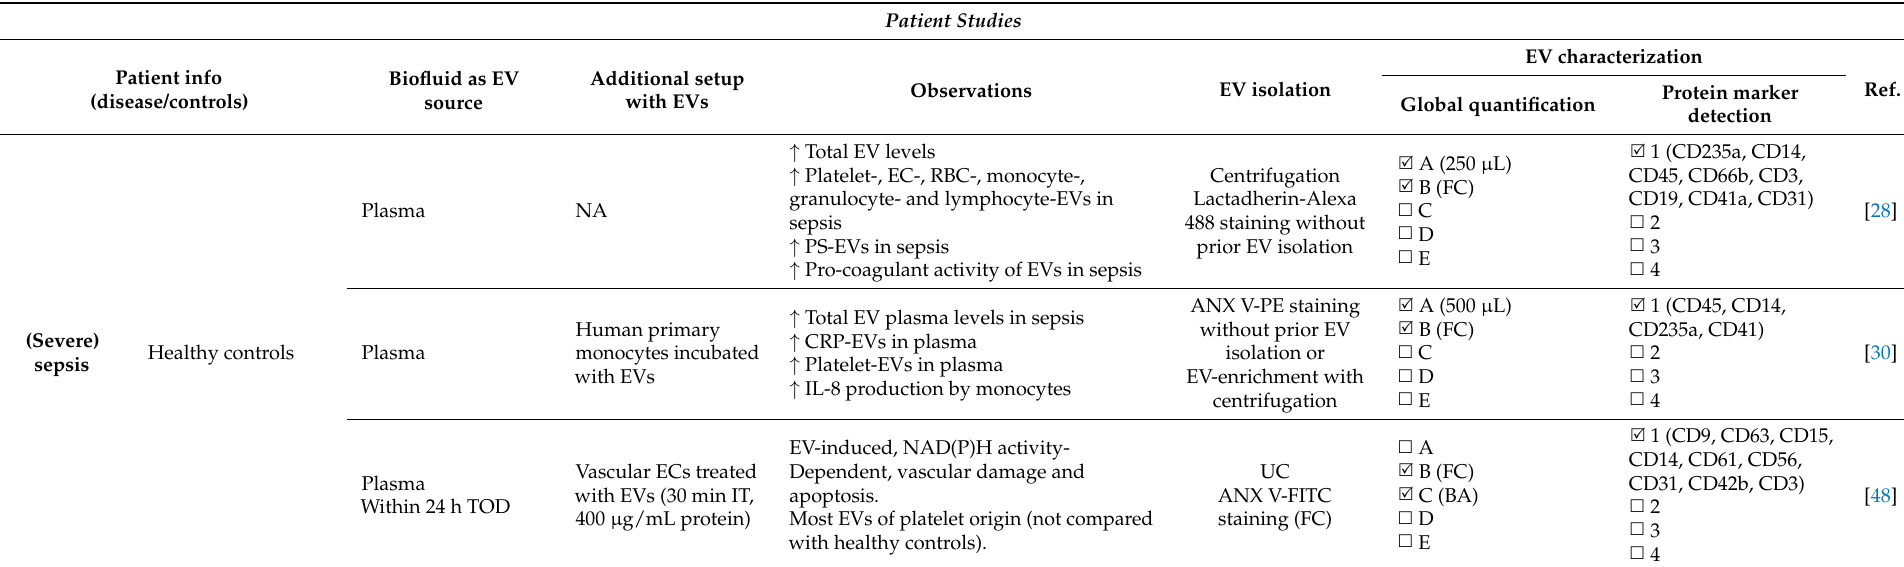
Table 3. Minimal Information for Studies of EVs (MISEV) guidelines related information about EV isolation and characterization in the studies discussed in this review, investigating human-derived EVs. When the effects of human EVs were validated in mice or cell cultures, this is mentioned as ‘additional setup’. For global quantification requirements, consult checkboxes A–E. Checkbox A: Cell number/fluid volume/tissue mass from which EVs were isolated. Checkbox B: Analysis of particle number. Checkbox C: Analysis of protein amount. Checkbox D: Analysis of lipid amount. Checkbox E: Analysis by electron microscopy. For information regarding protein marker detection, consult checkboxes 1–4. Checkbox 1: Transmembrane or Glycosylphosphatidylinositol (GPI)-anchored protein(s) localized in cells at plasma membrane or endosomes. Checkbox 2: Cytosolic protein(s) with membrane-binding or -association capacity. Checkbox 3: Assessment of presence/absence of expected contaminants. Checkbox 4: For small EVs < 200 nm: verifying protein(s) associated with compartments other than plasma membrane or endosomes. Abbreviations: extracellular vesicle (EV), not described (ND), not applicable (NA), time of diagnosis (TOD), post-admission (PA), incubation time (IT), culture medium (CM), lipopolysaccharide (LPS), cecal ligation and puncture (CLP), systemic inflammatory response syndrome (SIRS), Escherichia coli ( E. coli ), Staphylococcus aureus ( S. aureus ), Neisseria meningiditis ( N. meningitidis ), Streptococcus pyogenes ( S. pyogenes ), N-formyl-methionyl-leucyl-phenylalanine (fMLP), human umbilical vein endothelial cells (HUVECs), (CMECs), community-acquired pneumonia (CAP), fecal peritonitis (FP), fecal injection into the peritoneum (FIP), broncho-alveolar lavage (BAL), acute lung injury (ALI), acute respiratory distress syndrome (ARDS), disseminated intravascular coagulation (DIC), multiple organ dysfunction syndrome (MODS), intravenous (i.v.), intraperitoneal (i.p.), red blood cell (RBC),